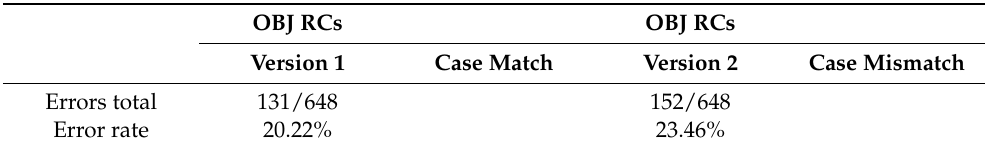
Table 3. Case and intervention